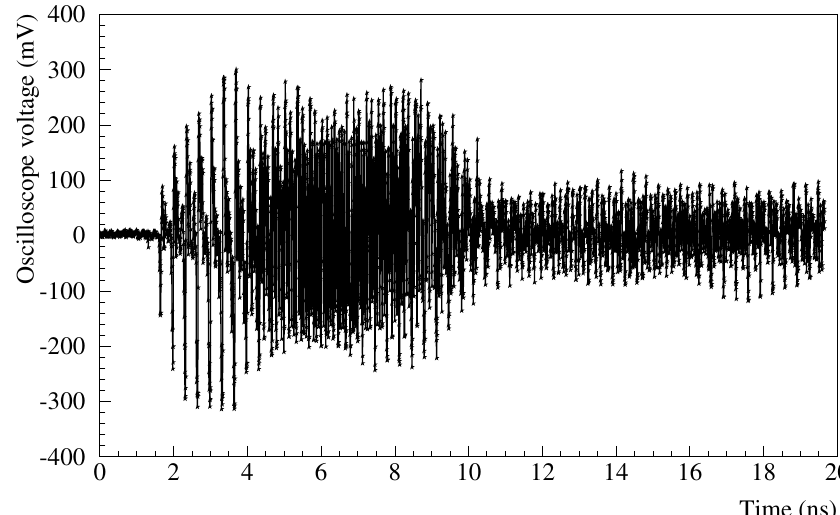
FIG. 30. Time structure of the signal induced in the pickup by the passage of a bunch train in the CTF3 ring after combination. The signal up to 4 ns is mainly a 3 GHz signal induced by one train; the high frequency signal from the combination is present mainly between 4 and 8 ns. The signals later than 10 ns are attributed to parasitic waveguide